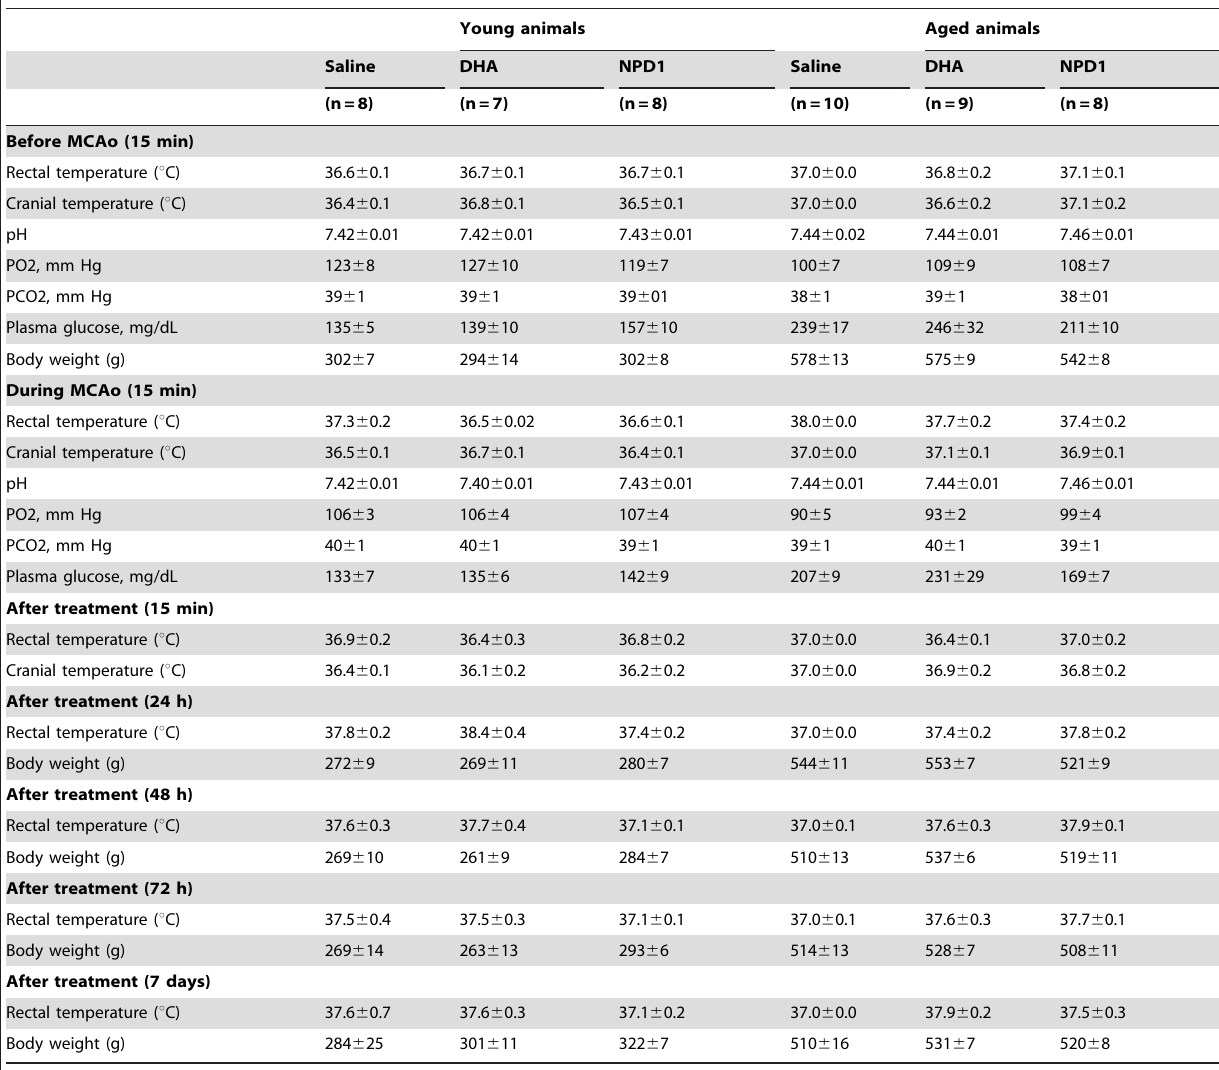
Table 1. Physiological Variables.